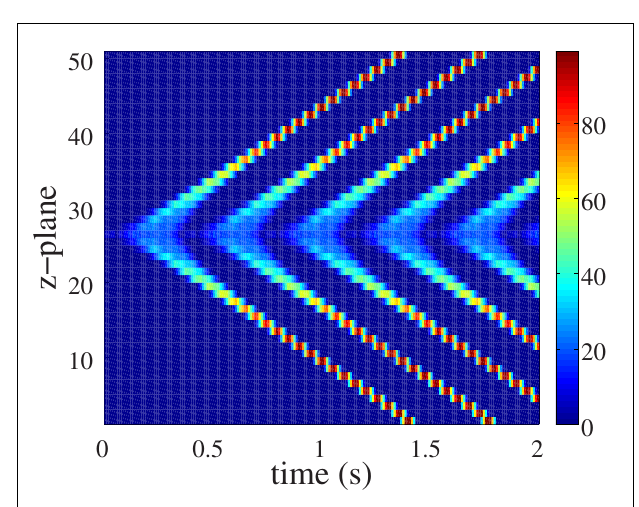
0.14s (C) , 0.20s (D) , 0.29s (E) , 0.33s (F) 0.36s (G) and 0.38s (F) .The triangular shape of the Ca 2 + concentration profiles is for illustrative purposes only. Other parameter values as in Table 1 .